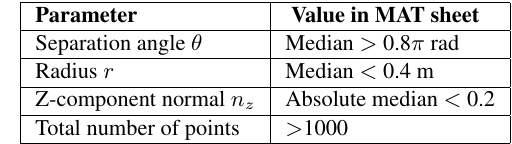
Figure 13. Resulting separate indoor spaces indicated with different colours, stairs and slopes shown in white respectively), and stairs and slopes are indicated with a red node at their top and bottom. Connectivity relationships are shown by the black lines. As can be seen, large spaces with multiple con- nections (such as the corridor and large hall) also have only one node. This makes routes that go through these spaces not always representative.